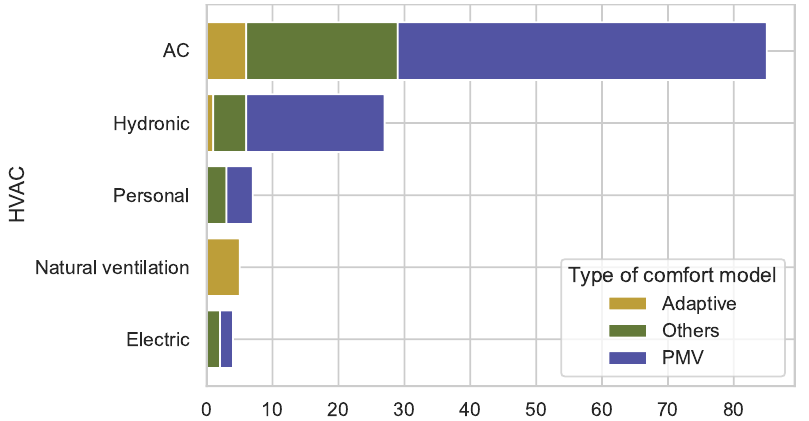
Figure 15. Type of comfort model by HVAC type (level of readiness simulation or prototype).